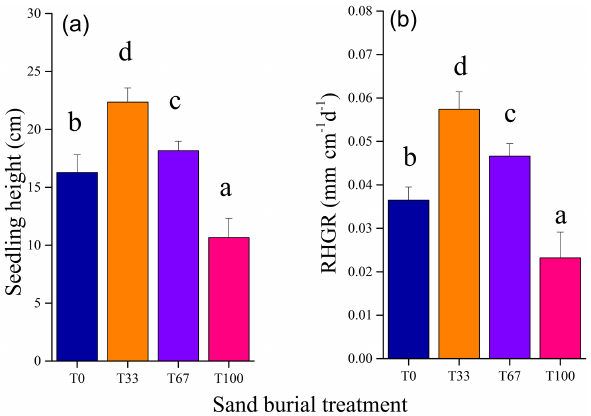
Figure 2. Seedling height and relative growth rate for height (RHGR) of Ulmus pumila var. sabulosa exposed to various sand burial treatments during a 45-day growth period. These treatments included sand burial of seedlings to a depth equivalent to 33 (T33), 67 (T67), or 100% (T100) of the mean seedling height at the ini- tiation of the study (see the Material and methods section for fur- ther details). Each histogram is the mean ± 1 standard error (SE) of n = 15. Different letters above histograms among seed burial depths are significantly different at P